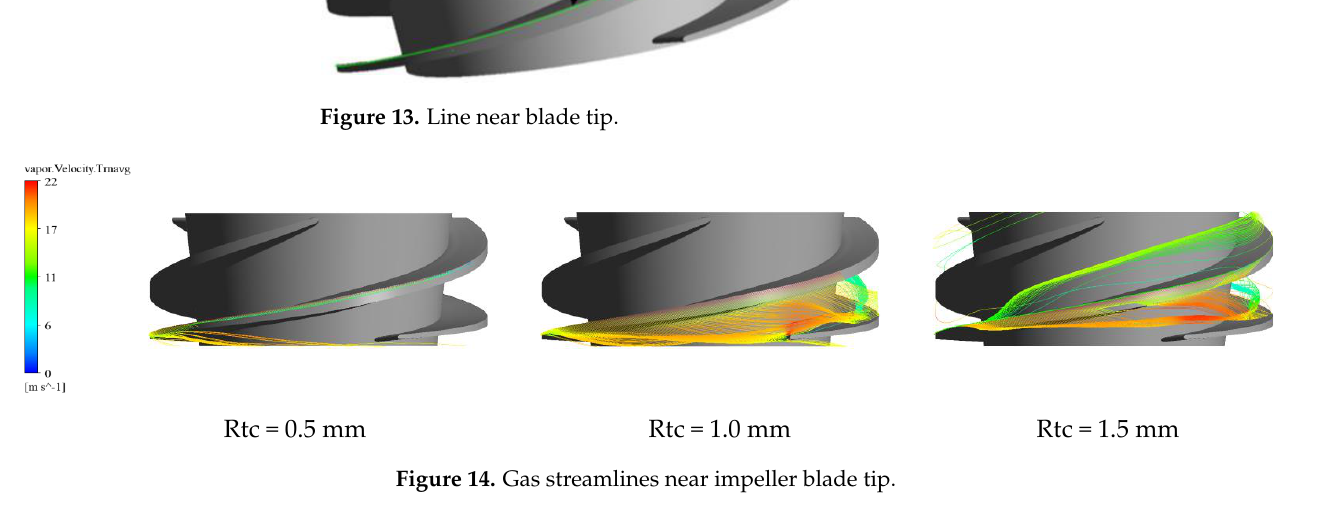
Figure 15. Gas-liquid velocity difference in impeller and diffuser along streamwise. For Figure 15, the velocity difference between the gas and liquid in impeller is large, and in the diffuser it is basically the same. This is because the impeller is the main energy conversion component, and the gas-liquid two-phase medium needs to complete the en- ergy conversion. The velocity and pressure are changed greatly. However, the diffuser is the rectification component, and the pressure variation is relatively small. In addition, the gas velocity is greater than the liquid velocity at the impeller inlet, rotor, and stator inter- face and diffuser outlet. However, the gas velocity is less than the liquid velocity at the other locations. The gas is more susceptible to disturbance, so its velocity is greater than that of the liquid. The liquid velocity in the impeller increases gradually along the stream- 0.0